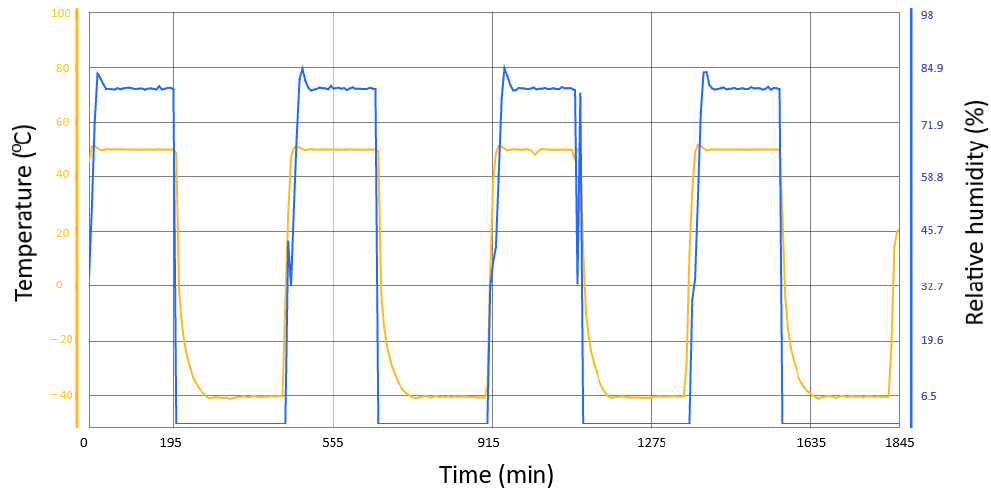
Figure 11. Exposure conditions of samples in a climatic chamber during the aging